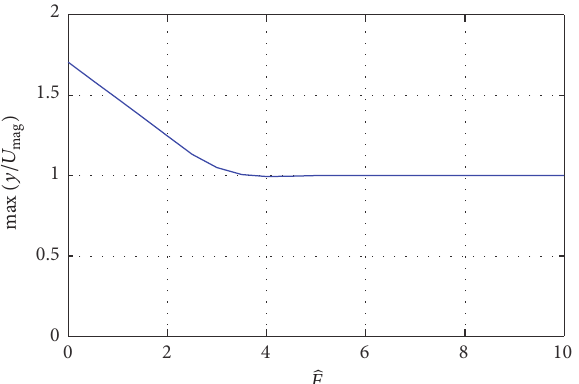
Figure 3: The maximum displacement of a single-degree-of- freedom model under versed sine base input when the level of friction is varied. Nondimensional base input magnitude 𝑈 and pulse length 𝑇 𝑝 = 𝑇 .